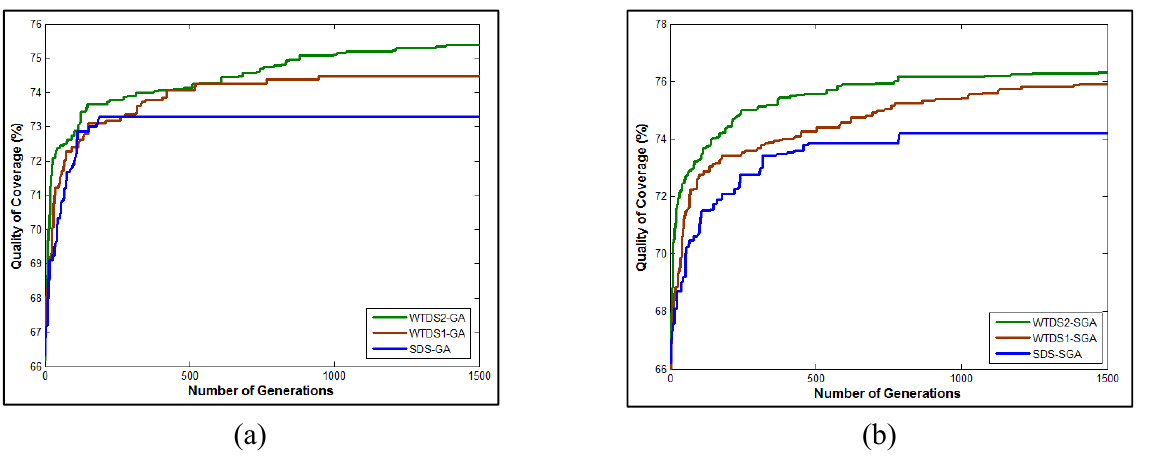
Figure 9. Comparison of the proposed methods ( a ) three standard GA methods ( b ) three steady state GA methods.